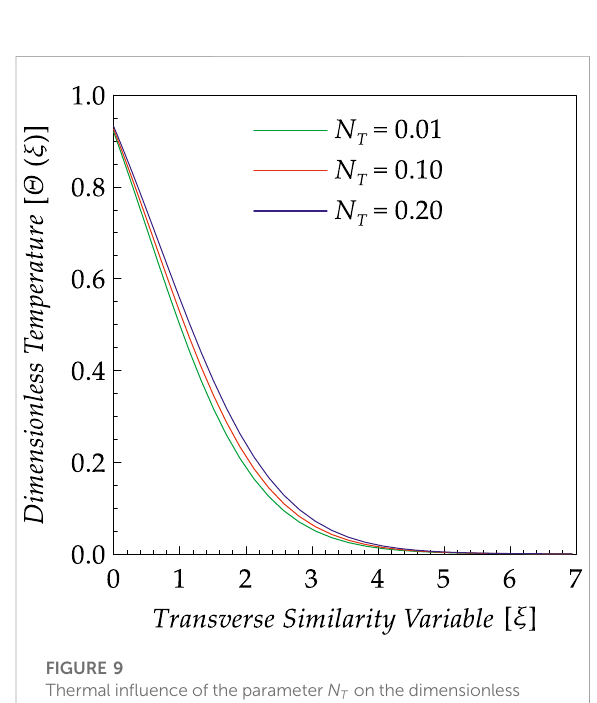
FIGURE 9 Thermal in fl uence of the parameter N T on the dimensionless temperature Θ ( ξ ) .